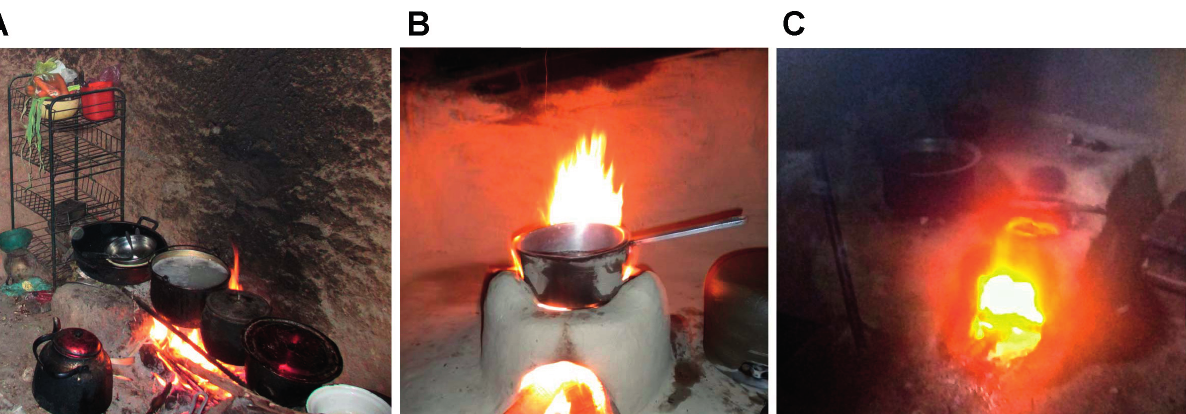
Figure 1. Traditional, open-fire, biomass burning cookstoves in Peru ( A ); Nepal (B) and Kenya ( C